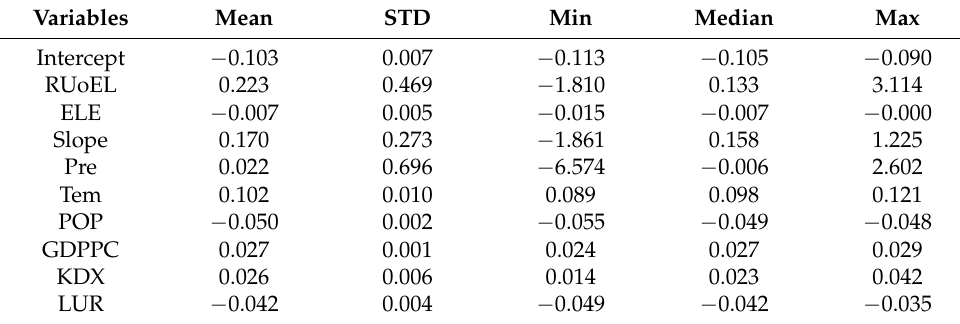
Table 1. Descriptive statistics of each